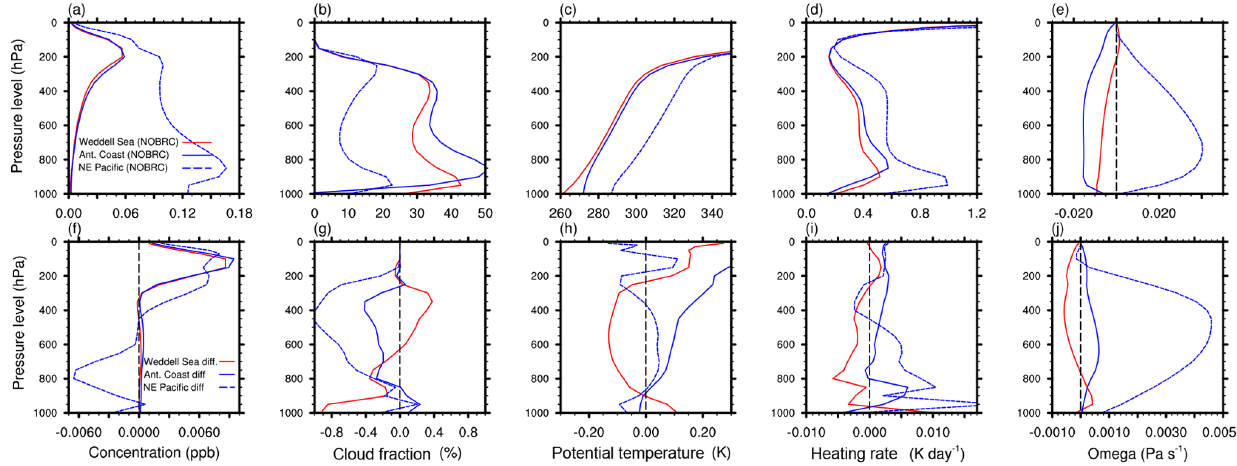
Figure 10. Vertical profiles (a–e) and vertical profile perturbations (f–j) for the sites in the Weddell Sea (WC) and the Antarctic coast (AC). In (a) – (e) the model run NOBRC is plotted, and the difference between BRC and NOBRC is plotted in (f) – (j) . Red represents regions with a positive REari and blue represents regions with a negative REari.